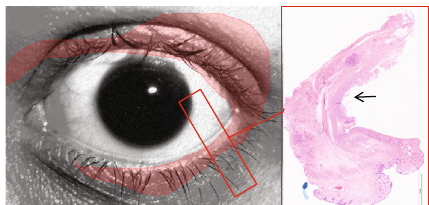
Figure 1: Case 3. Orbital exenteration. Circumferential sectioning of the eyelids and soft tissue allowed for mapping tumor extension which is nearly 360 ° (tumor spread = red area). Grossly, only slight fi rmness was present in the temporal/lacrimal gland area. Histopathologically, the tumor involves the dermis, palpebral conjunctiva, and periorbital soft tissue (arrow).